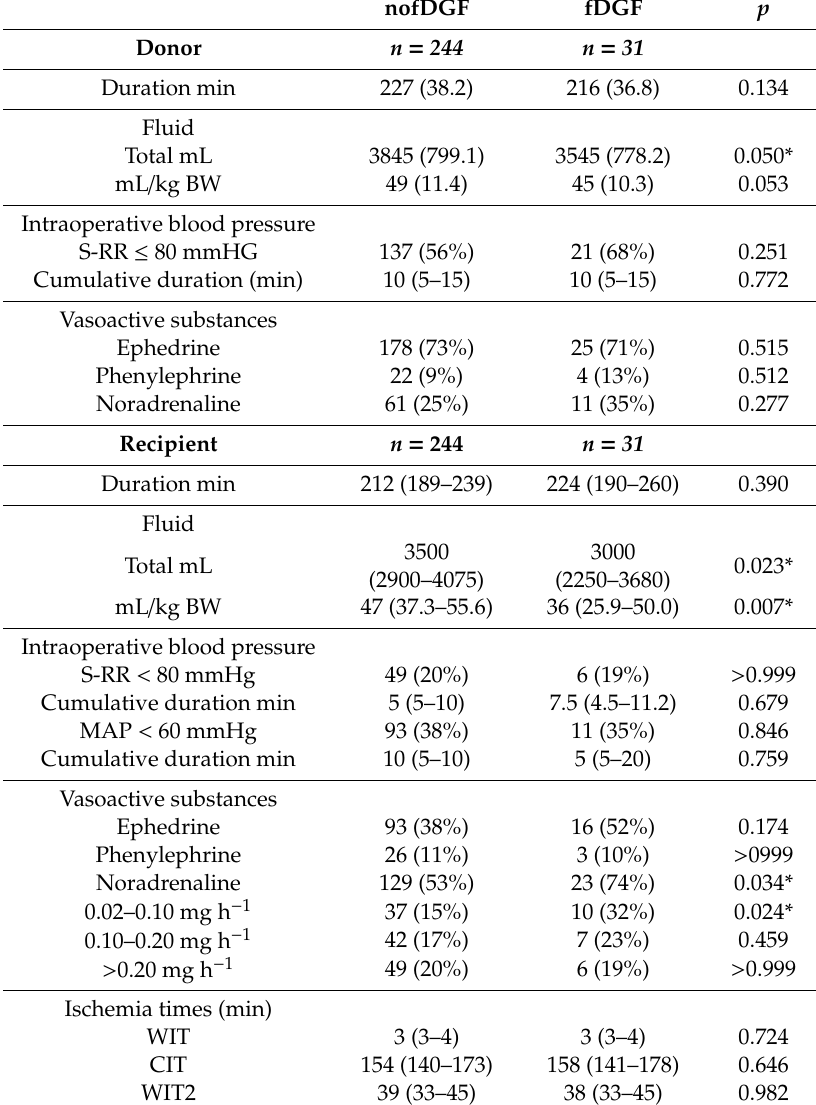
Table 2. Intra- and postoperative donor and recipient data. Data given as number (%), mean (SD), or median